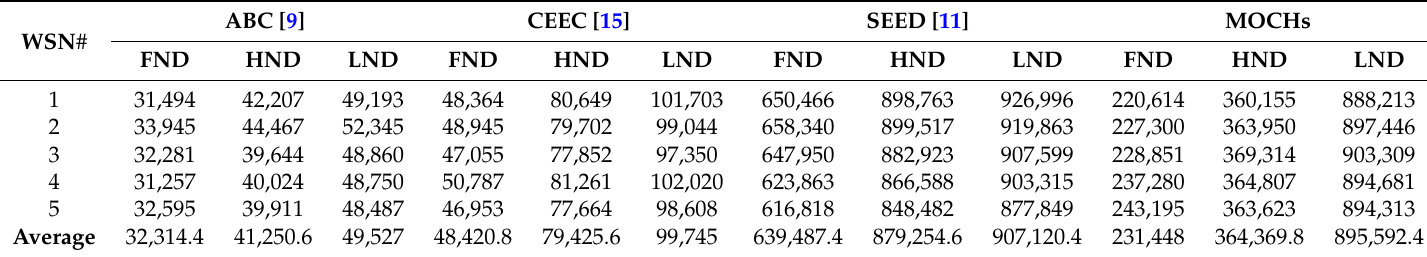
Table 7. Total number of data packets received at the BS over simulations of five WSNs (with 300